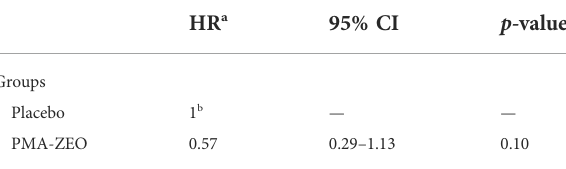
TABLE5AdjustedmultivariateCoxregressionanalysisforthe fi rst-line treatment